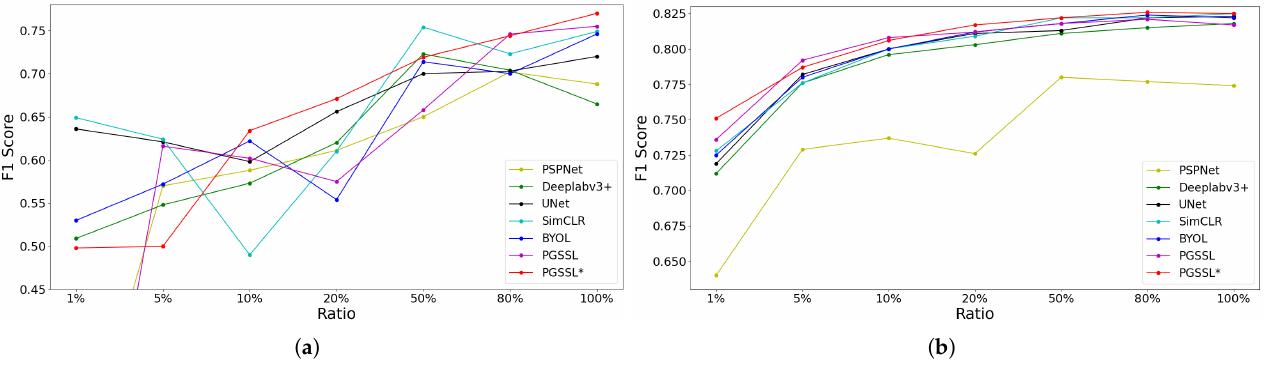
Figure 8. The effect diagram of the accuracy changes of various methods under different proportions of training data. ( a ) Effects on the BJ dataset. ( b ) Effects on the EA dataset.